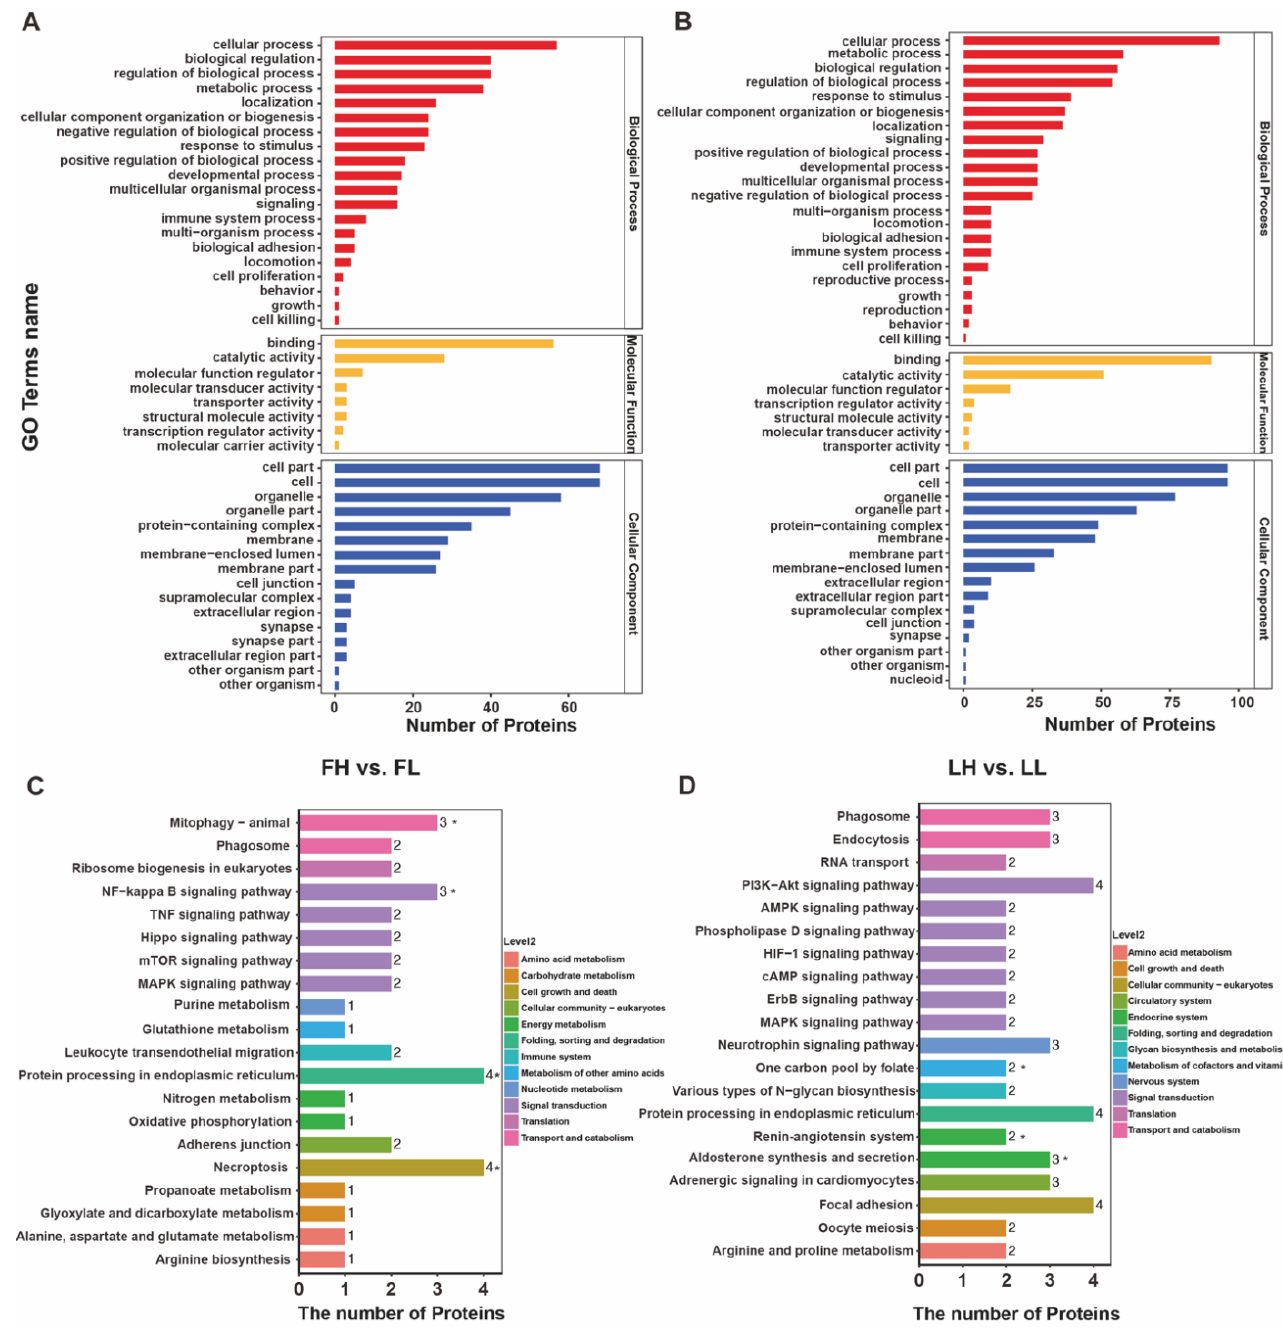
Figure 5. Gene ontology (GO) and Kyoto Encyclopedia of Genes and Genomes (KEGG) pathway enrichment analyses of differentially abundant proteins (DAPs) in the oviduct. GO annotation of DAPs in FH vs. FL ( A ) and LH vs. LL ( B ) comparison groups. KEGG classification of DAPs in FH vs. FL ( C ) and LH vs. LL ( D ) comparison groups. * Presents significant difference at p < 0.05.